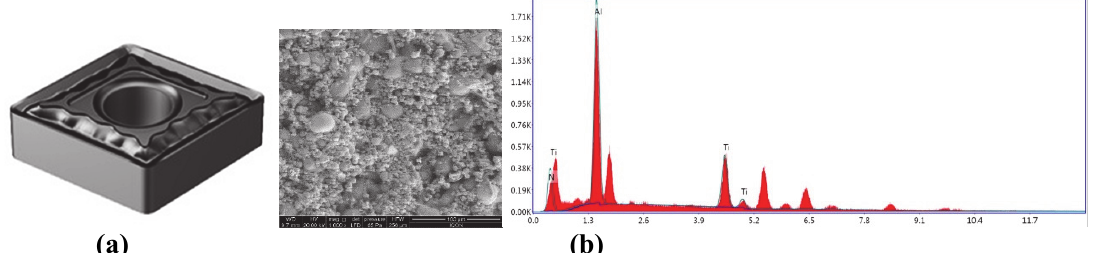
Fig. 3. Photographic view of (a) PVD TiAlN insert (b) Surface morphology and EDAX profile of PVD TiAlN